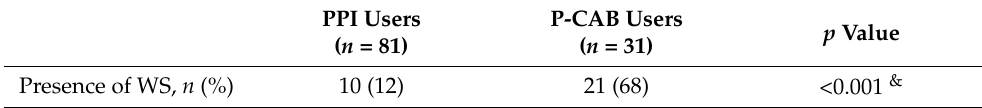
Table 2. Prevalence of white spot in PPI users versus P-CAB users within the A-SA group. PPI Users P-CAB Users p Value ( n = 81) ( n = 31) Presence of WS, n (%) 10 (12) 21 (68) <0.001